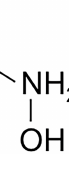
Figure 1. Hydroxyurea (HU).